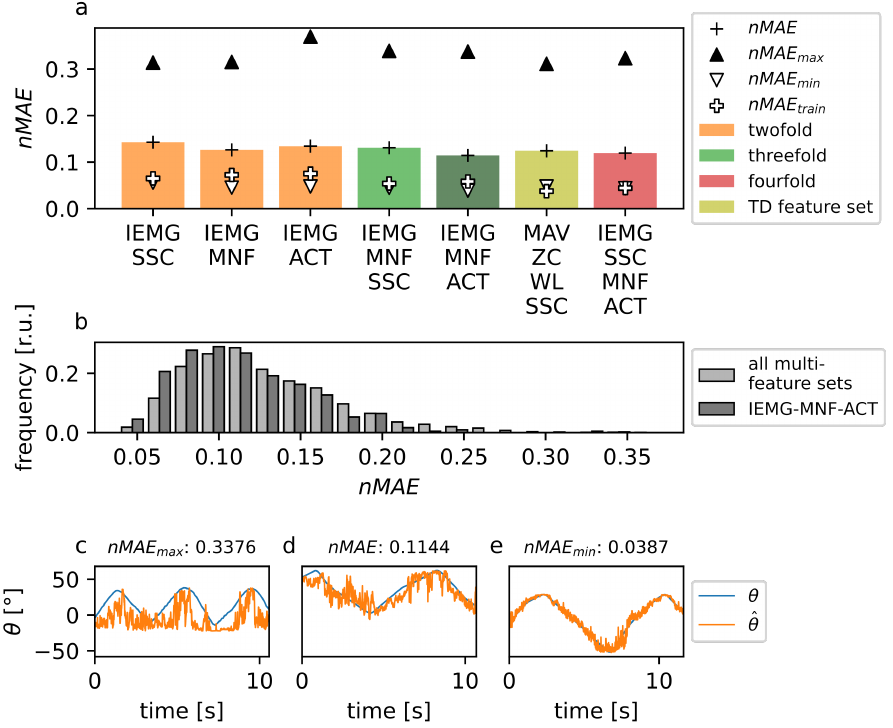
Figure 8. Average prediction performance of FFNN models trained with different multi-feature combi- nations using an offset of ( δ =) 0.3s, a segment length of ( T =) 0.3s and an overlap corresponding to a 100Hz feature signal frequency. ( a ) Mean absolute errors for elbow-motion prediction based on twofold ( orange ), threefold ( green ), fourfold ( red ) feature combinations, and the TD feature set ( yellow ). The different symbols depict the prediction error ( nMAE ) using the test data set ( black plus sign ), the corresponding minimum ( nMAE min ; white arrow ), and maximum ( nMAE max ; black arrow ) prediction errors, as well as the prediction errors for the training data set ( nMAE train ; white plus sign ). ( b ) Nor- malized frequency distribution of prediction errors for all multi-feature combinations (light gray bars) and the IEMG-MNF-ACT feature (dark gray bars), which yielded the highest predictive accuracy ( dark green color in ( a ) ). ( c – e ) Exemplary plots of an experimentally recorded elbow-joint angle θ ( blue ) and the corresponding model prediction ˆ θ ( orange ) based on the IEMG-MNF-ACT feature with an offset of ( δ =) 0.3s and a segment length of ( T =) 0.3s: ( c ) prediction with the highest prediction error ( nMAE max = 0.3376), ( d ) model prediction closest to the mean prediction error ( nMAE =